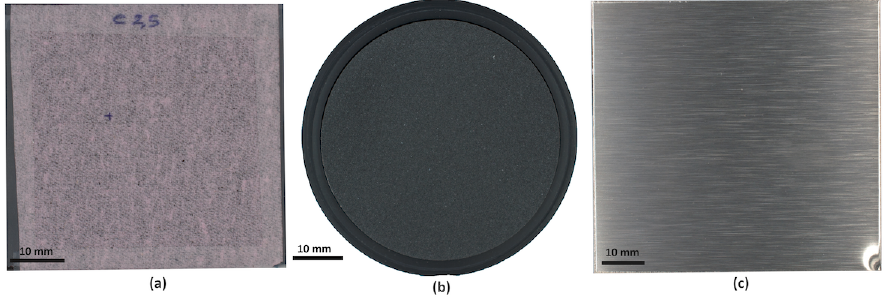
Figure 2. Surface samples: ( a ) S 1 = industrial paper, ( b ) S 2 = Spectralon ® Diffuse Reflectance Standard (SRS-05-020), and ( c ) S 3 = metallic brushed or polished